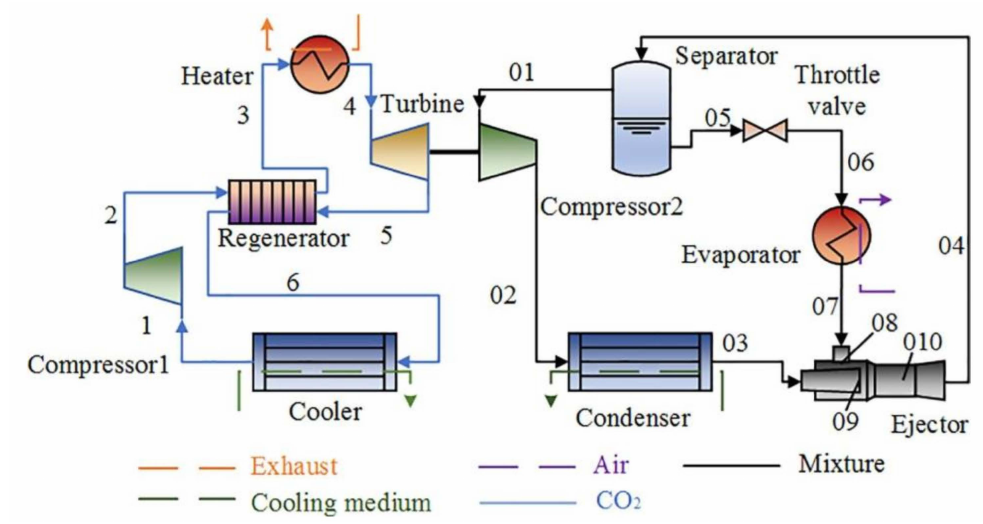
Figure 25. Schematic diagram of the combined cycle RSCBC/EERC. Reprinted from ref. [74], Copy- right (2020), with permission from Elsevier.